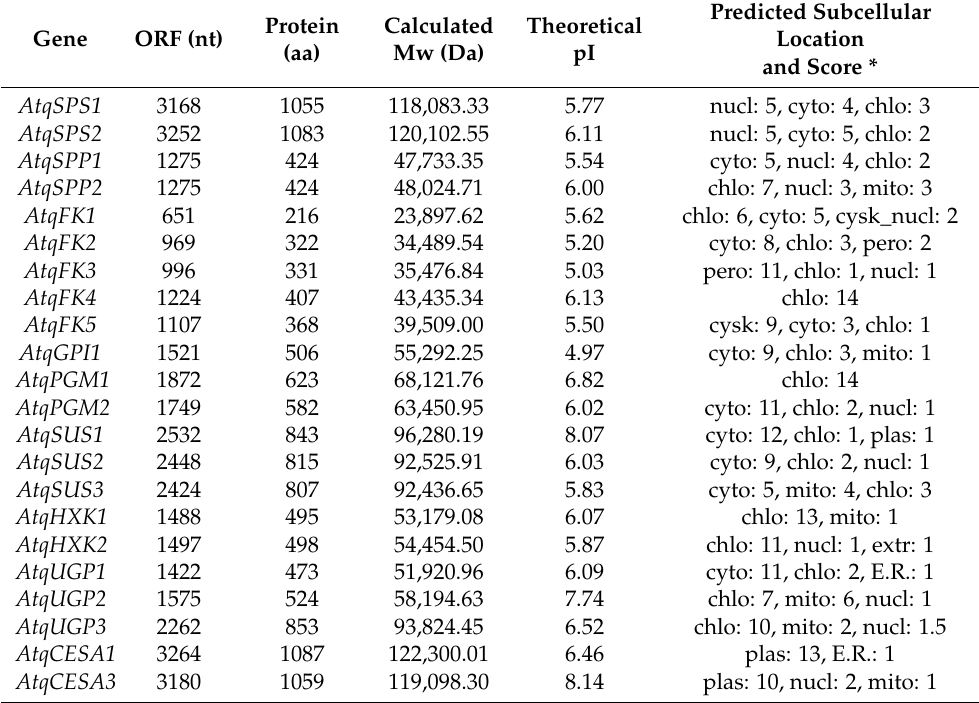
Table 1. Detailed sequence information of genes involved in cellulose biosynthesis in Agave tequilana